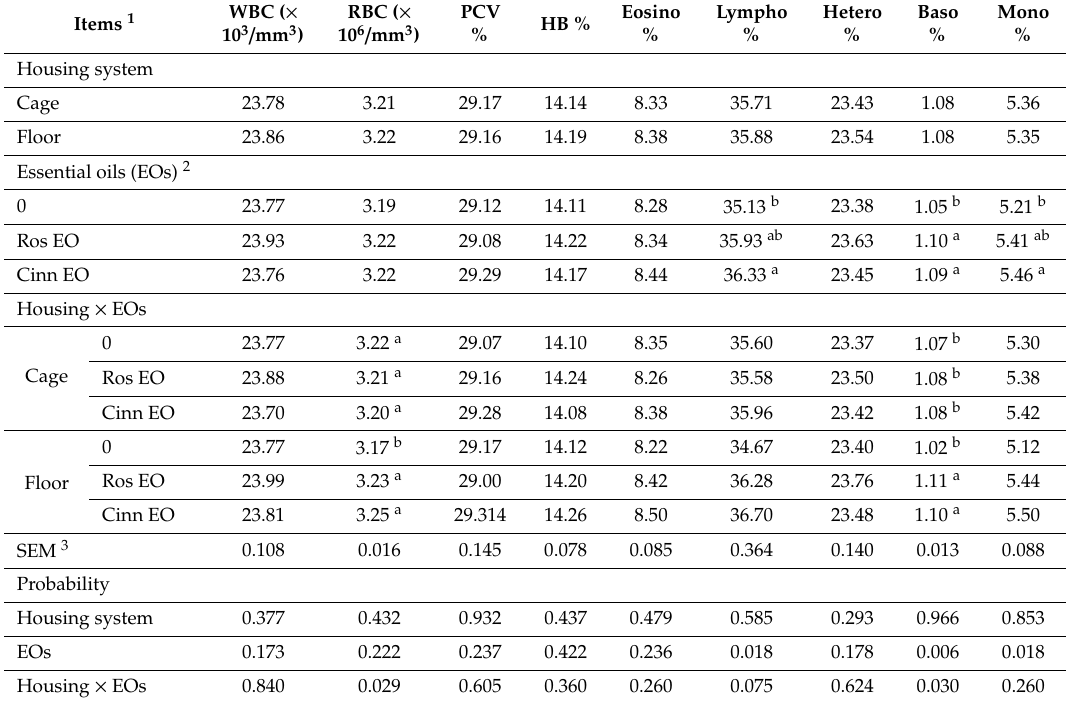
Table 8. Blood picture of laying hens as a ff ected by di ff erent housing systems, essential oils and their interaction during the